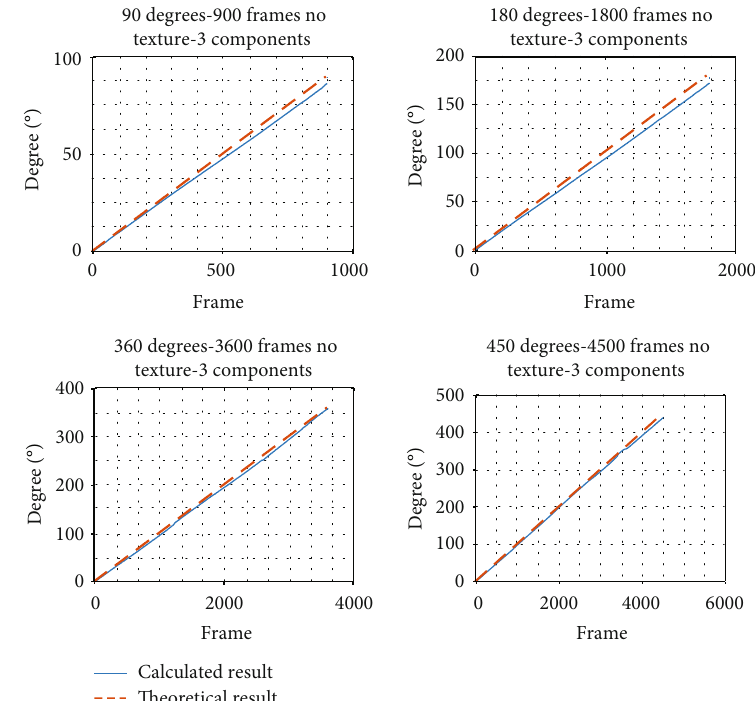
Figure 5: Angle estimation of model (a) under di ff erent rotation angles (10 frames per degree).